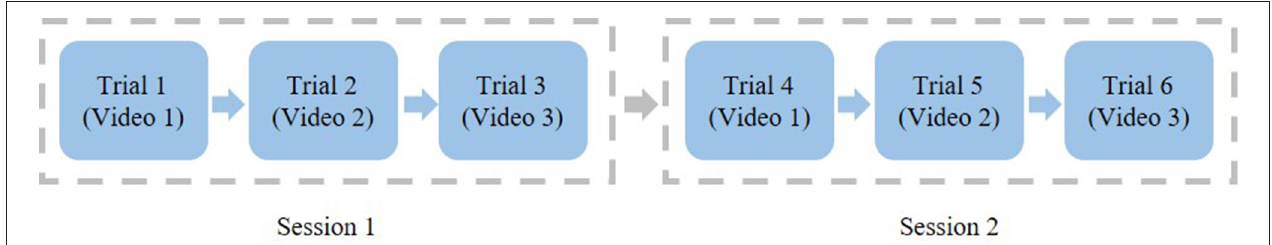
FIGURE 3 | The experimental procedure for a subject.